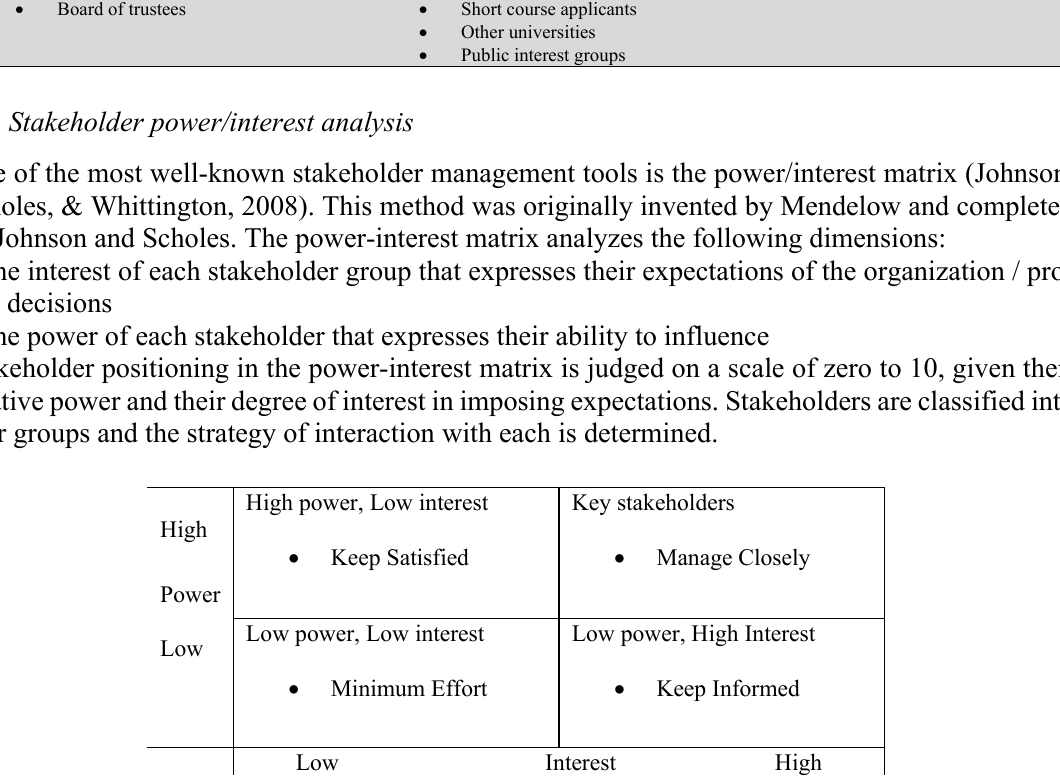
Fig. 2. Stakeholder classification and related strategies in the Power/Interest matrix (Johnson, Scholes, & Whittington,